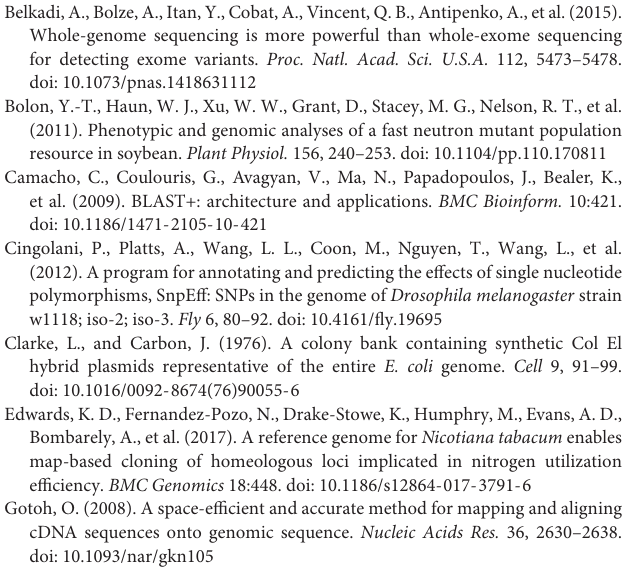
Supplementary Table 4 | Translated target (bait) locations in the Nitab-v4.5_wes combined sequence set. Supplementary Table 5 | Whole-exome sequencing (WES) statistics for 19 NtEMS lines and a technical replicate. Supplementary Table 6 | Mutations detected in target regions of the 19 NtEMS lines with 160 × whole-exome sequencing data. Supplementary Table 7 | Proportions of the mutations detected in the 19 NtEMS lines that were single-nucleotide variations (SNVs). Supplementary Table 8 | Number of mutations per 10 Mb genomic segment in the target regions on the 24 tobacco